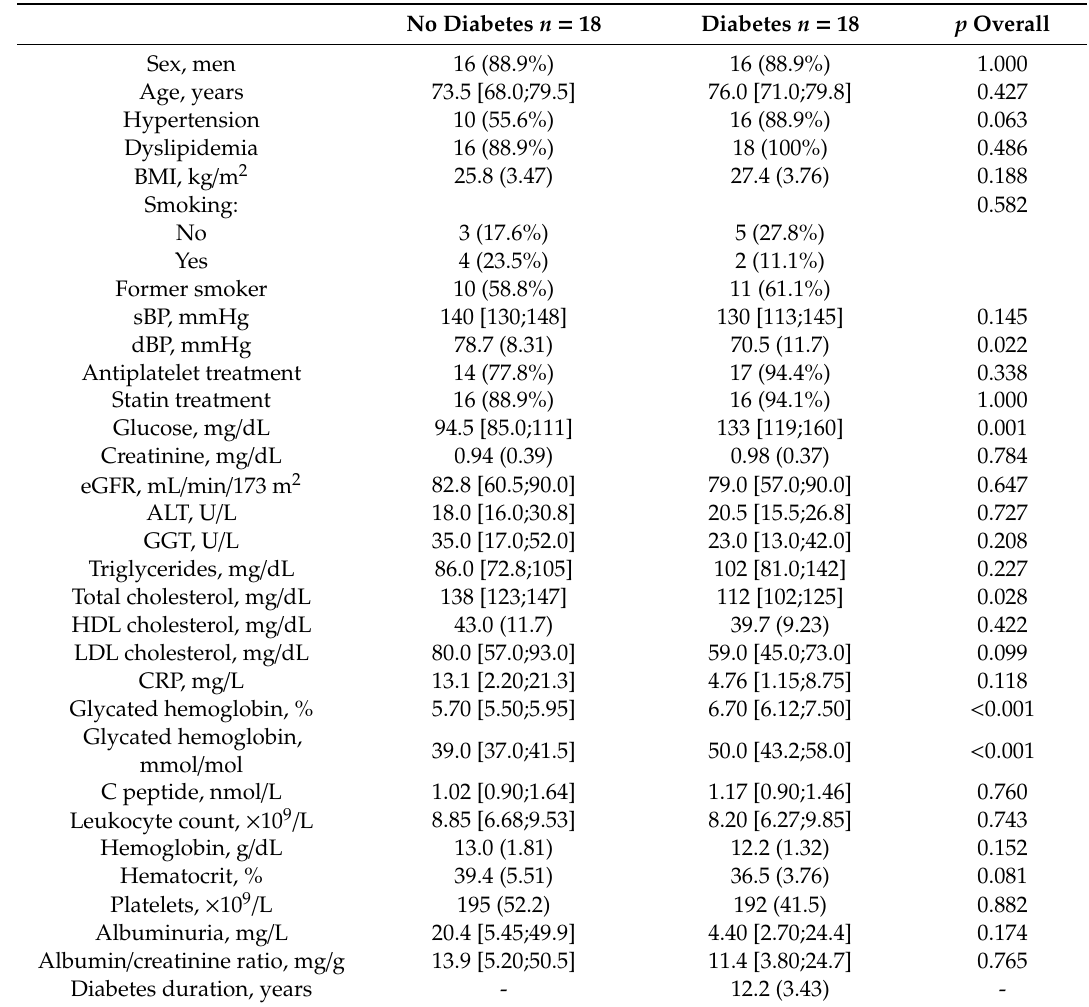
Table 1. Clinical characteristics of the study